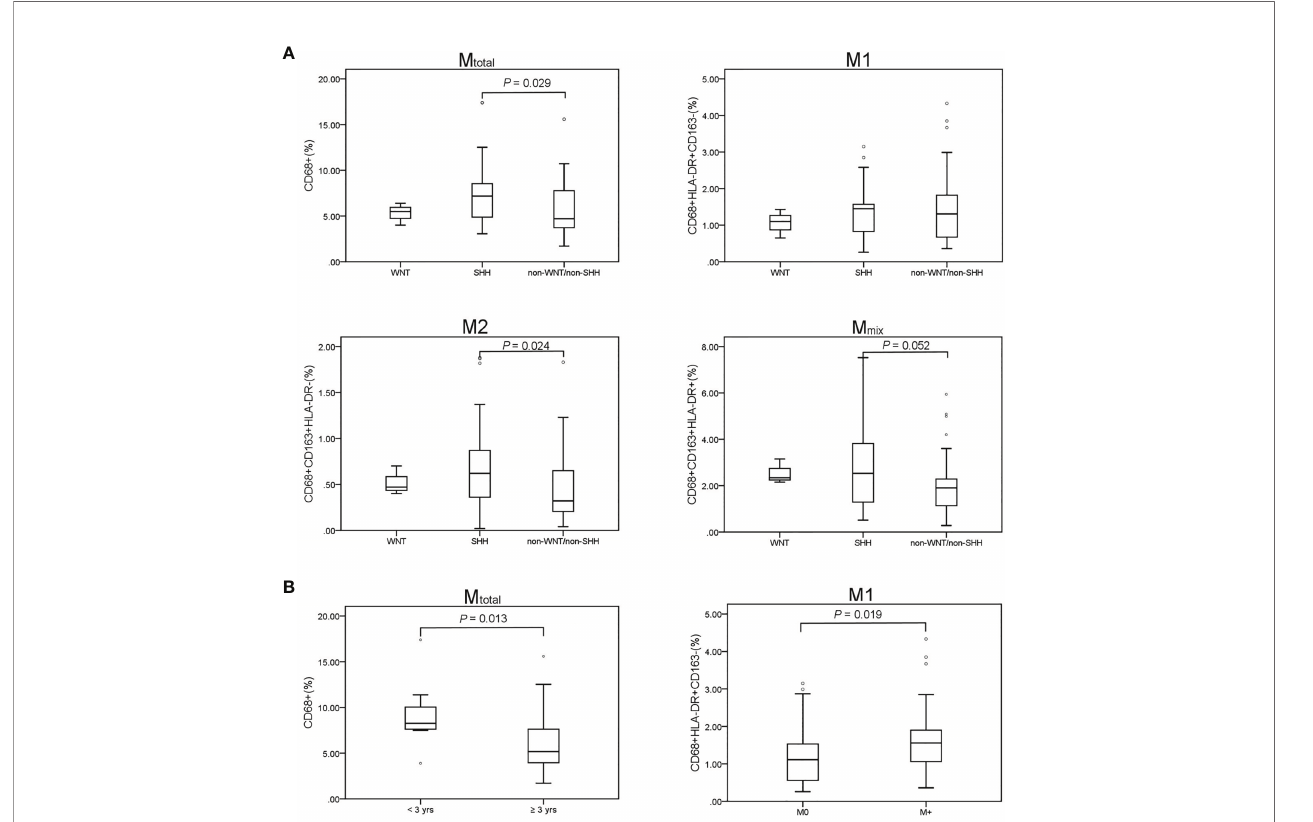
FIGURE 2 | TAM recruitment in medulloblastoma patients. Results of the Mann – Whitney U test are presented. Only signi fi cant results are displayed. (A) Comparison of TAM recruitment in the medulloblastoma subgroups. WNT (n = 3), SHH (n = 29), non-WNT/non-SHH (n = 39). M total ( P = 0.029) and M2 ( P = 0.024) were signi fi cantly higher in the SHH subgroup than those in the non-WNT/non-SHH subgroup. M mix percentage tended to be higher in SHH than that in non-WNT/non- SHH ( P = 0.052). No difference was revealed in M1 proportion ( P = 0.941). (B) M total was signi fi cantly higher in children younger than 3 years ( P = 0.013). M1 in metastatic group was signi fi cantly higher than that in non-metastatic group ( P = 0.019). M0, non-metastatic group; M+, metastatic group. °,